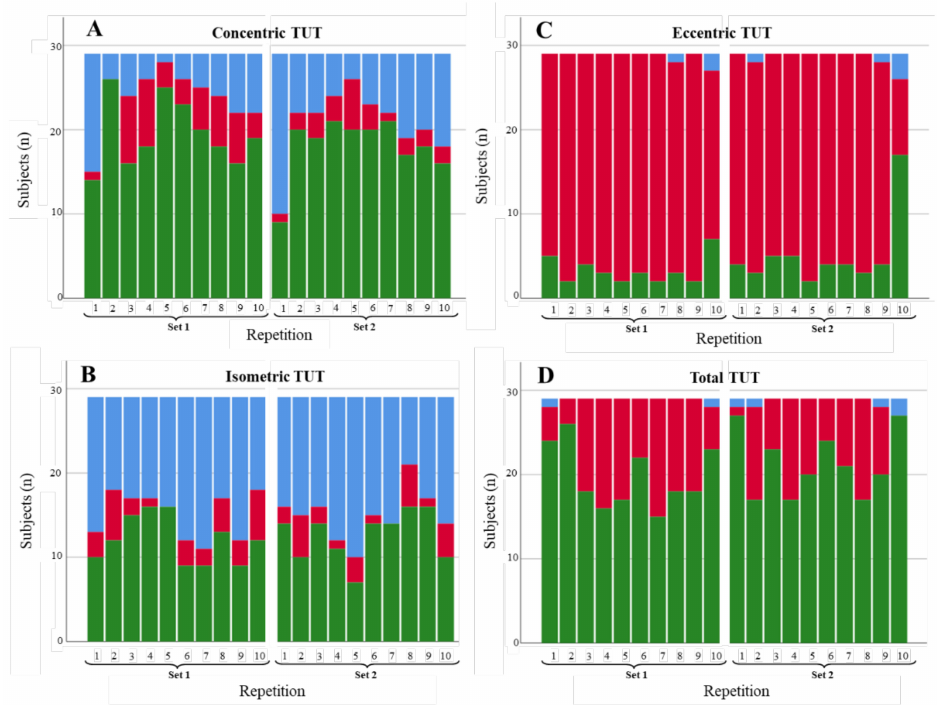
Figure 4. Degree of compliance of the TUTs for the slow abduction scenario by contraction phase: ( A ) concentric, ( B ) isometric, ( C ) eccentric, and ( D ) total. TUTs: in range = green; performed in less time than expected = blue; performed in more time than expected =